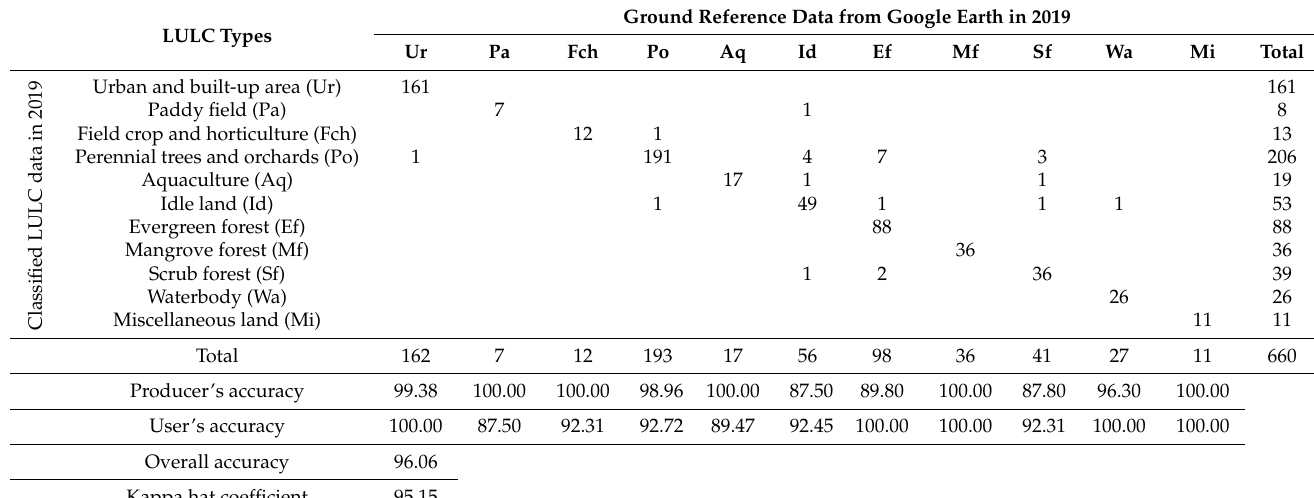
Table 8. Error matrix and accuracy assessment of the LULC map in 2019.